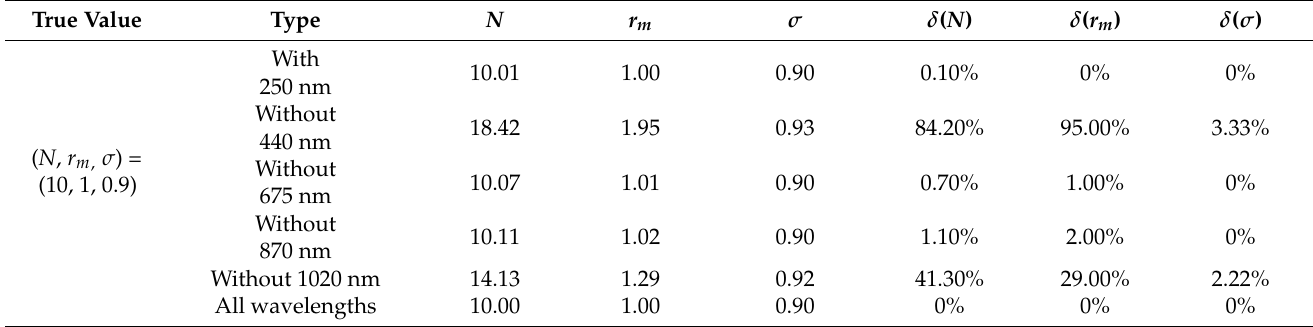
Table 5. The inversion results under different wavelength